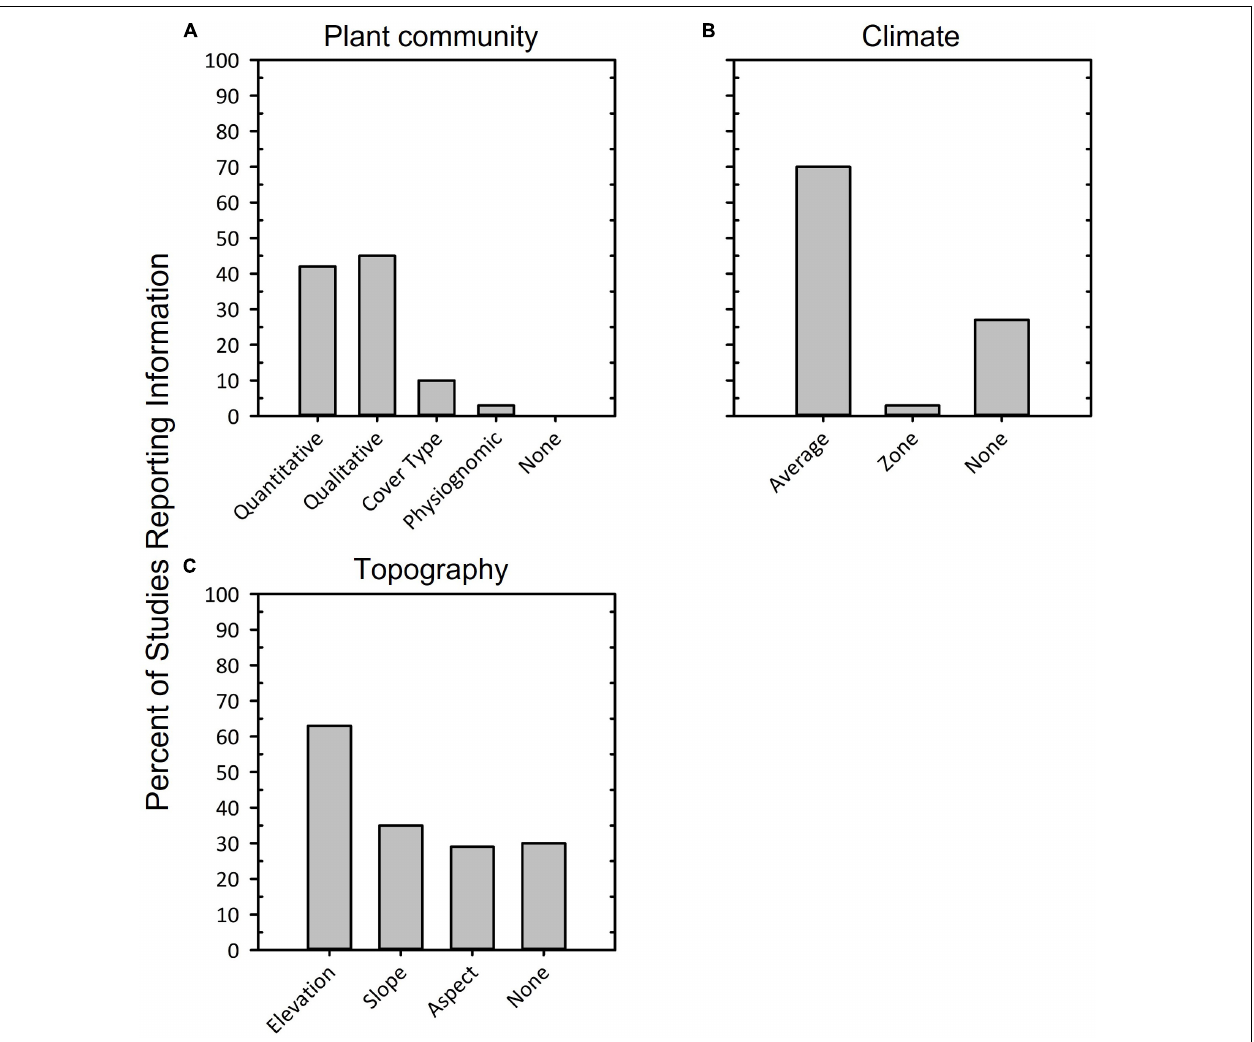
FIGURE 2 | Plots showing the level of detail to which authors reported (A) plant community, (B) climate, and (C) topography in recent prescribed fire